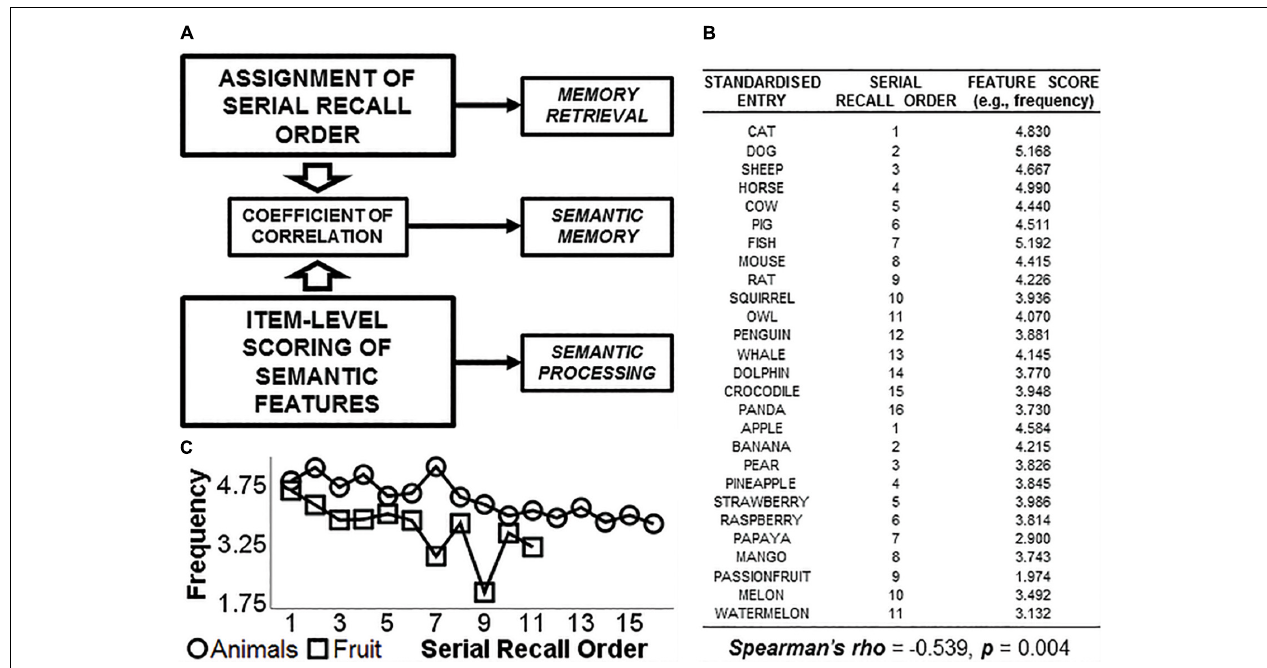
FIGURE 1 | Graphical representation of the principle at the basis of the study. While the serial order of recall is a property of memory retrieval, features such as word “frequency,” “typicality,” or “age of acquisition” are linked to semantic processing. The calculation of a coefficient of correlation between these two variables would produce an index that can inform how retrieval from memory is associated with semantic “difficulty” of words, and thus provide a theoretically valid measure of semantic memory (A) . On the right, a practical example of feature-to-feature correlation between “serial recall order” and “frequency” (B) . This is illustrated in the bottom left corner (C)